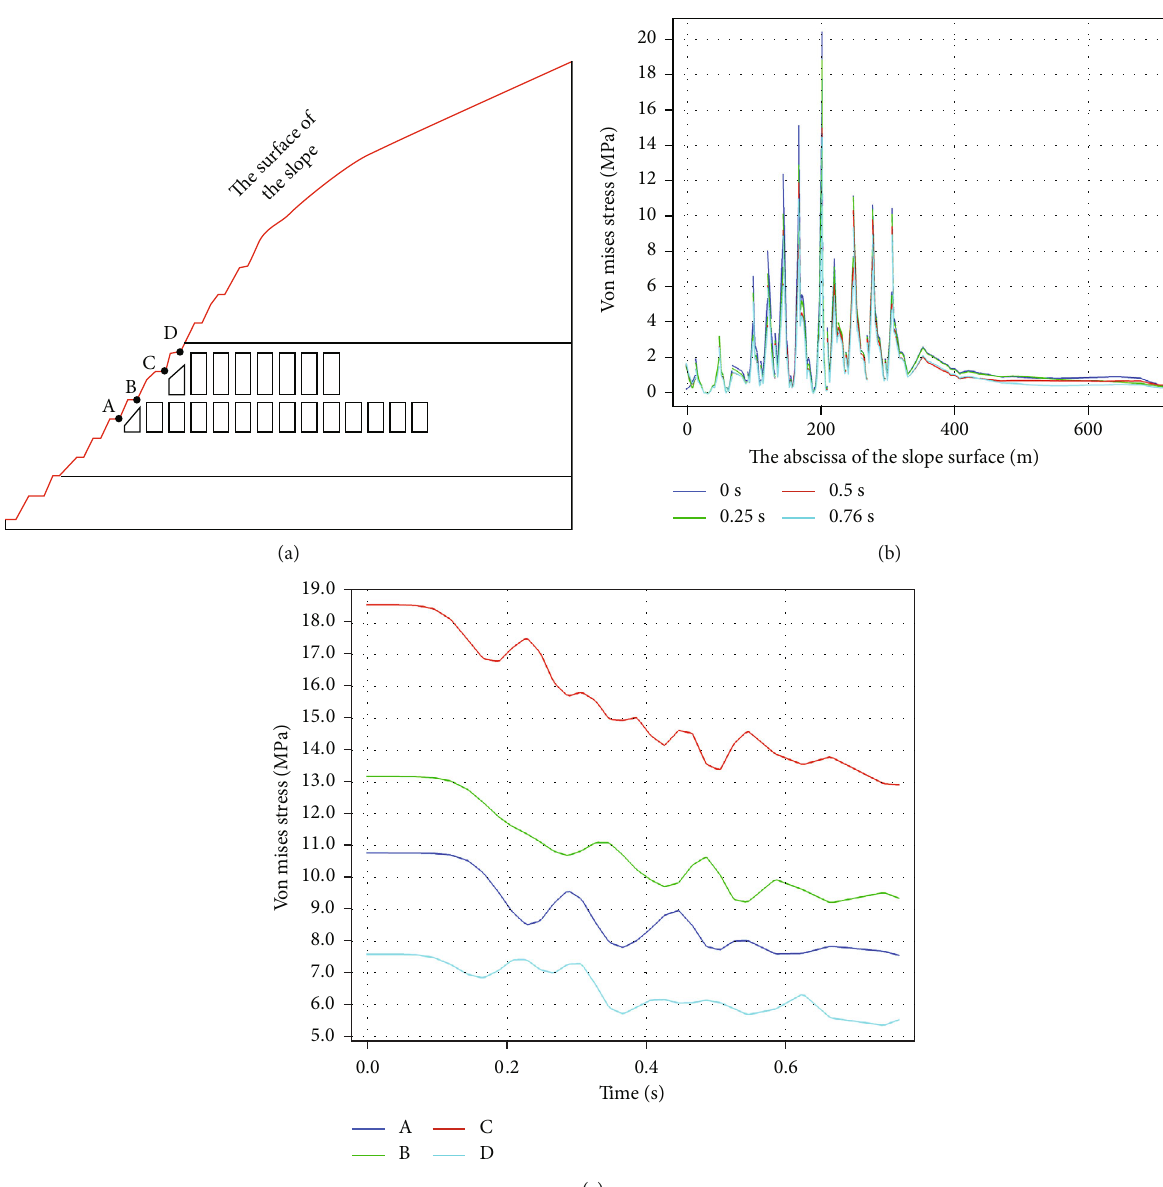
Figure 7: von Mises stress changing situation of the slope and hanging-wall ore mine under blasting vibration: (a) schematic diagram of calculated position of slope and hanging-wall ore mine; (b) von Mises stress changing law of slope surface with di ff erent blasting time; (c) von Mises stress changing law of points A, B, C, and